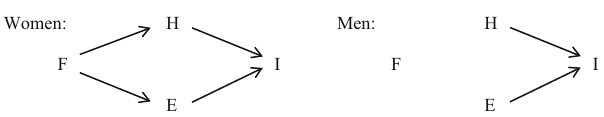
Fig. 1 Causal diagram for the effect of family formation on income for women and men. ( F family formation, I income, H hours worked, E job experience. Based on Bobbitt-Zeher [2007, p.